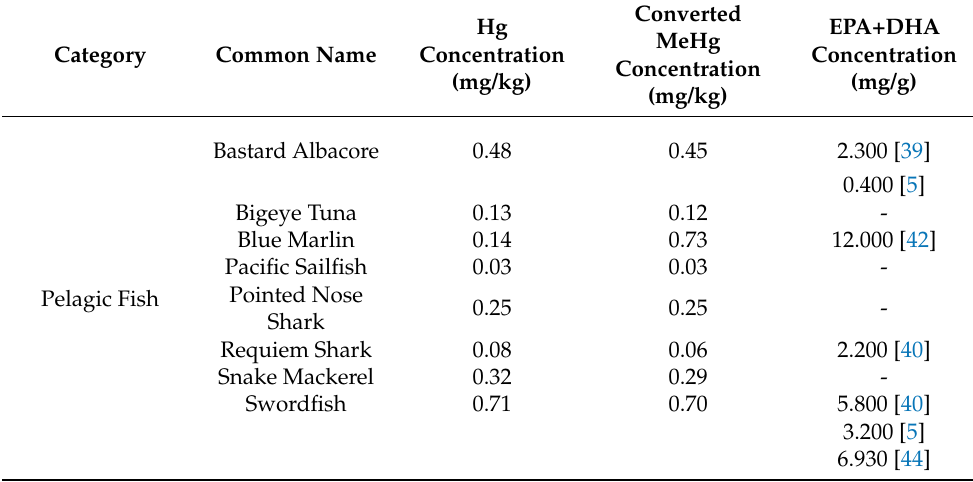
Table A1. Mercury and EPA+DHA concentrations in different